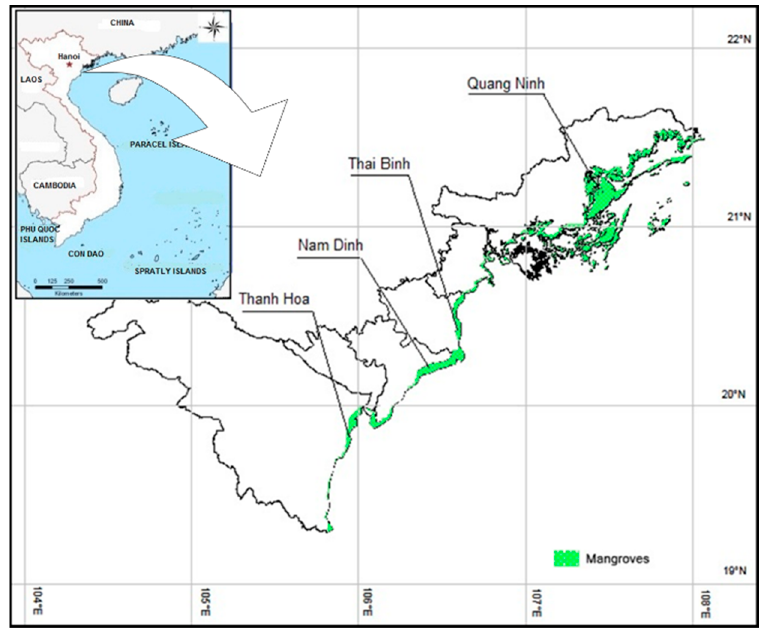
Figure 1. Location of study sites in northern Vietnam.